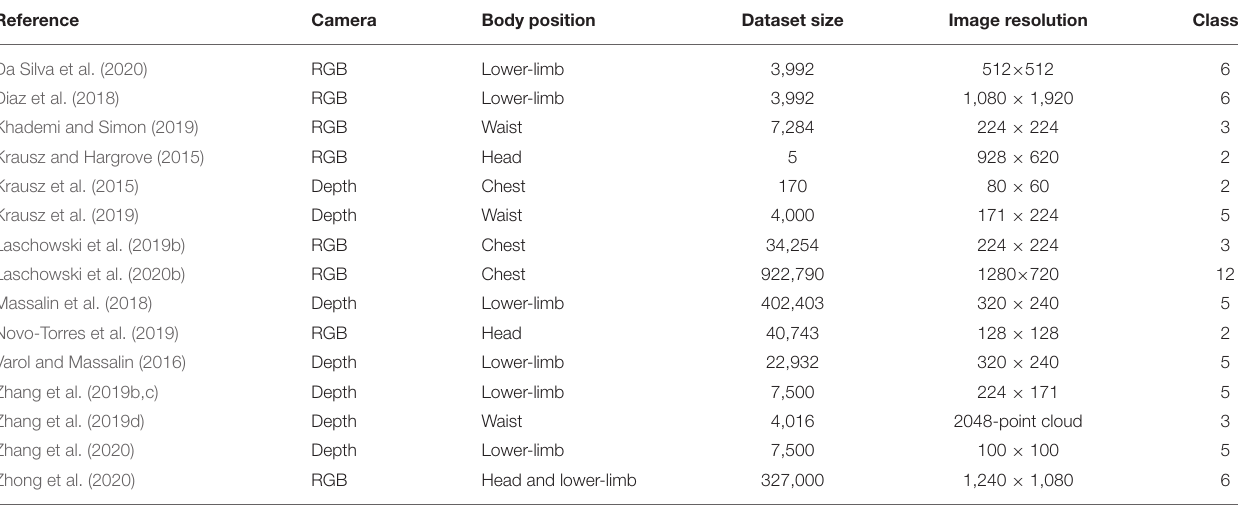
TABLE 1 | Experimental datasets used for image classification of walking environments for robotic leg prostheses and exoskeletons.